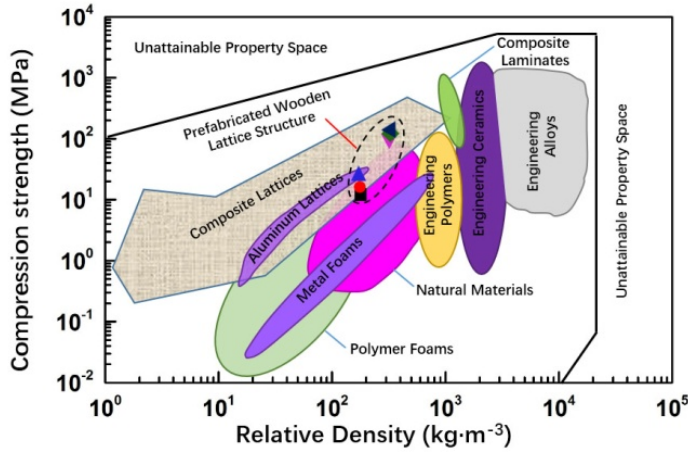
Figure 13. Relationship between compressive strength and density of materials [27].